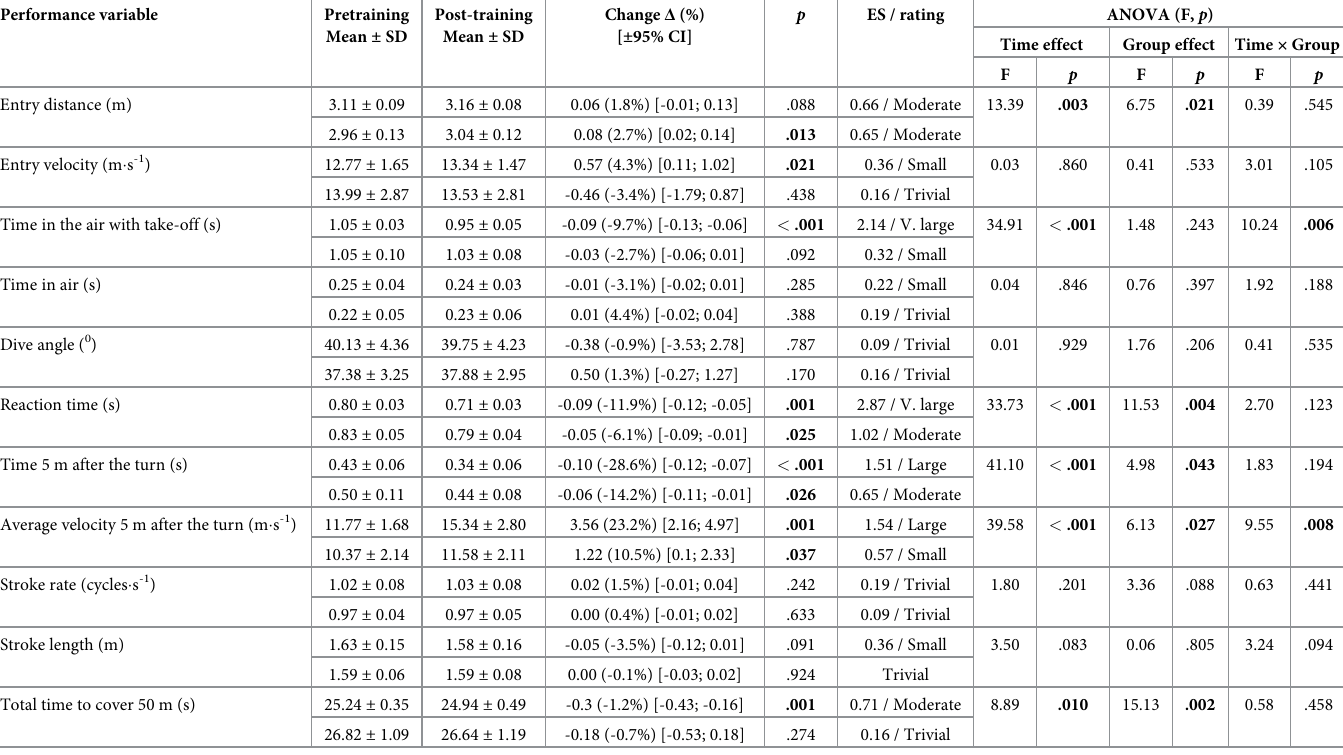
Table 4. Pre- and post-training values of the performance variables for swimmers. In each data block, the upper row is for the EG, and the lower row is for the CG. Performance